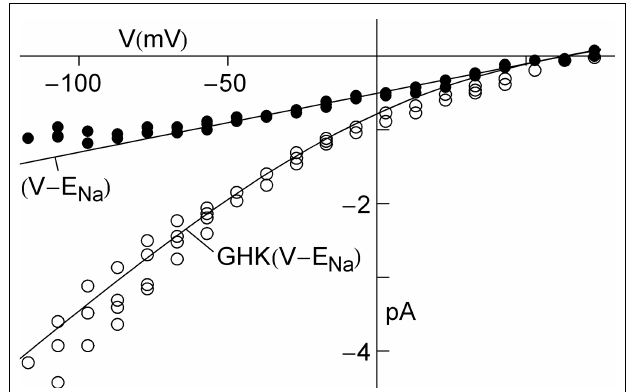
FIGURE 8 | GHK analysis of Na + current in squid giant axons (Vandenberg and Bezanilla, 1991). The open circles were obtained using divalent-free artifi cial seawater. The fi lled circles were obtained under normal divalent cation conditions, Ca 2 + = 10 mM and Mg 2 + = 50 mM. The latter results are well described by ( V − E ) over the range of potentials spanned by an action Na potential ( − 70 to + 40 mV) because of partial, voltage-dependent block of I Ca 2 + and Mg 2 + .